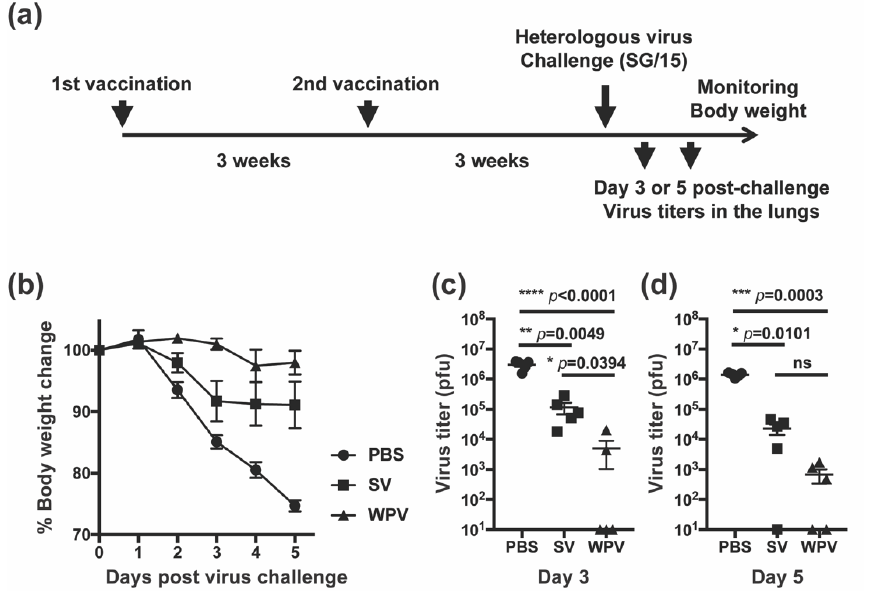
Figure 1. Protectivity of WPV and SV against heterologous virus challenge. ( a ) Schematic representation of the experimental schedule. C57BL/6 mice were subcutaneously inoculated with PBS or 9 µ g of protein of monovalent CA/09 WPV or SV twice at 3-week intervals. Following the second vaccination, mice were challenged intranasally with 3000 PFU of SG/15. ( b ) The change of body weight of mice was calculated as a percentage of the original weight at 0 days post-infection (dpi). Five mice in each group were euthanized for the collection of lung samples at 3 and 5 dpi. ( c , d ) Plaque assays were performed to calculate the lung viral titers at 3 ( c ) and 5 dpi ( d ). Samples that had undetectable plaques were assigned a value of 10 for graphing purposes. Dots represent individual values, and lines indicate the mean values with SEM ( n = 10 per group). ( a – c ) The circles, squares, and triangles indicate data from mice inoculated with PBS, SV, and WPV, respectively. * p < 0.05, ** p < 0.01, *** p < 0.0005, **** p < 0.0001, one-way ANOVA using a multiple-comparison correction; ns indicates not significant ( p >